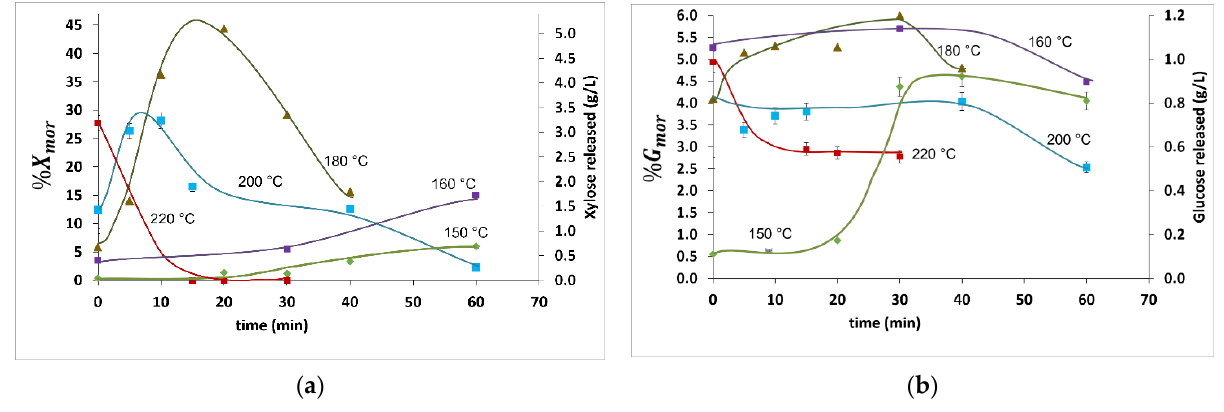
Figure 2. Polymers release to monomers as a function of isothermal reaction time and temperature of ( a ) xylose (%X mr ) and ( b ) glucose (%G mr ). Data points represent the averages of 3 experiments. Error bars represent standard uncertainties.